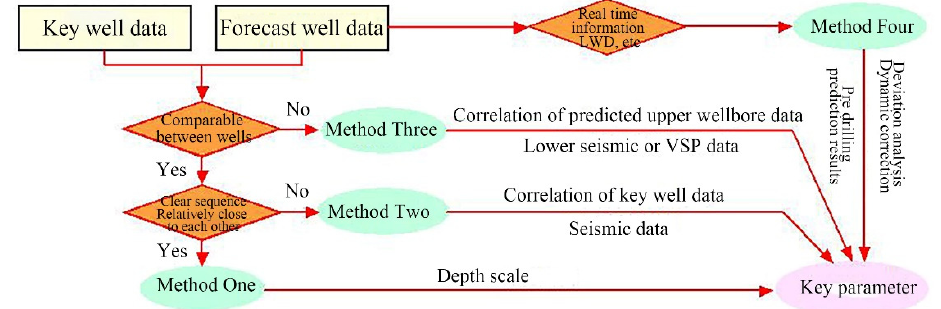
Figure 2. Main methods for predicting key risk factors.